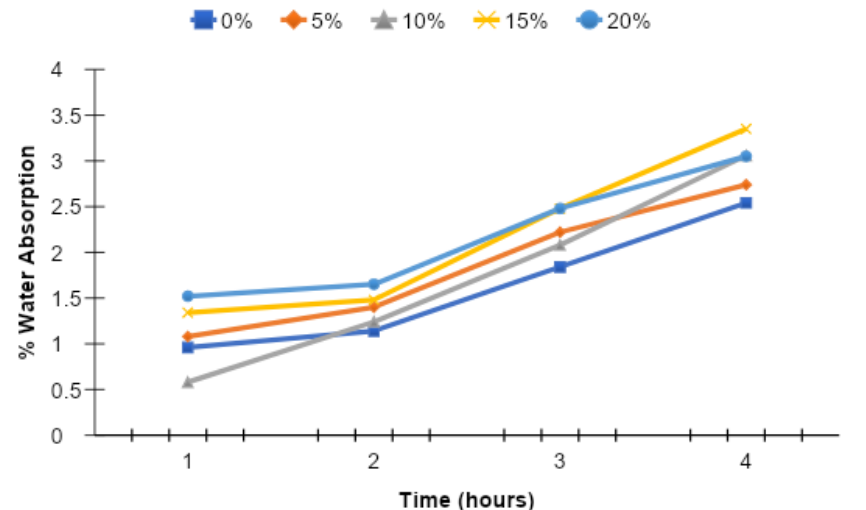
Figure 16. Rate of change of percentage water absorption for all mixes.